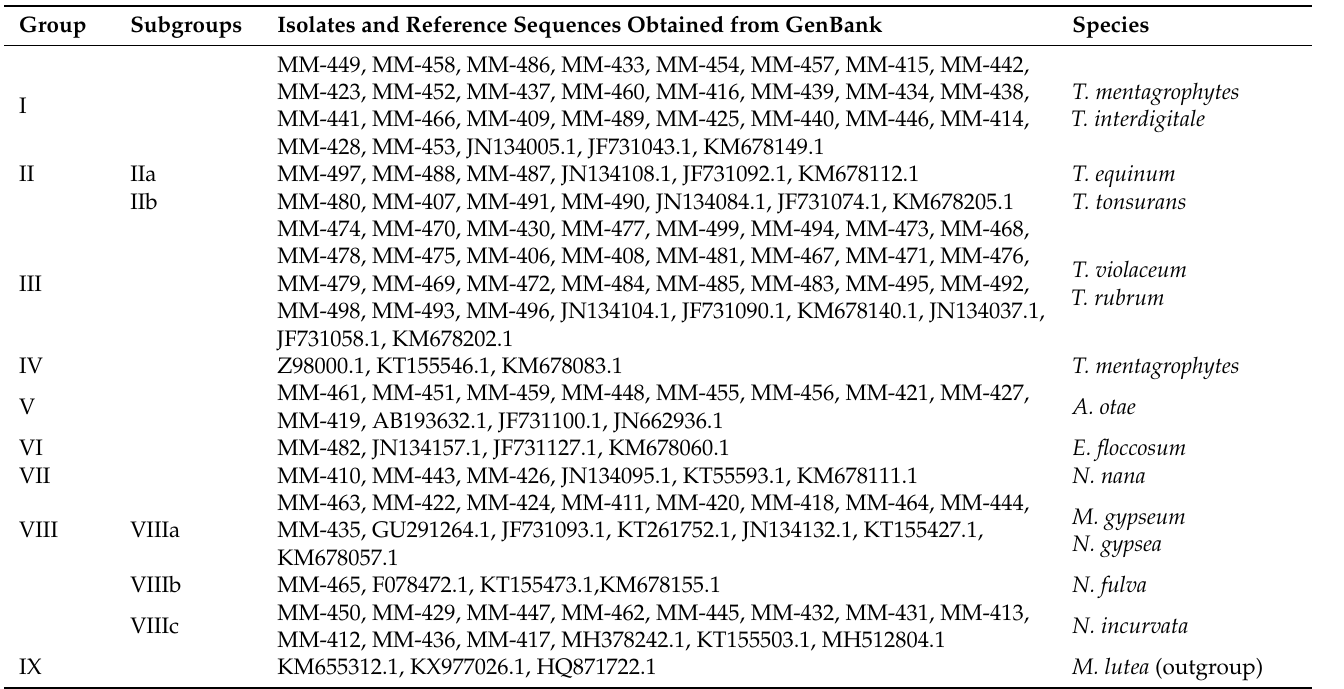
Table 3. Genotypic identification of dermatophyte isolates included in the study using maximum